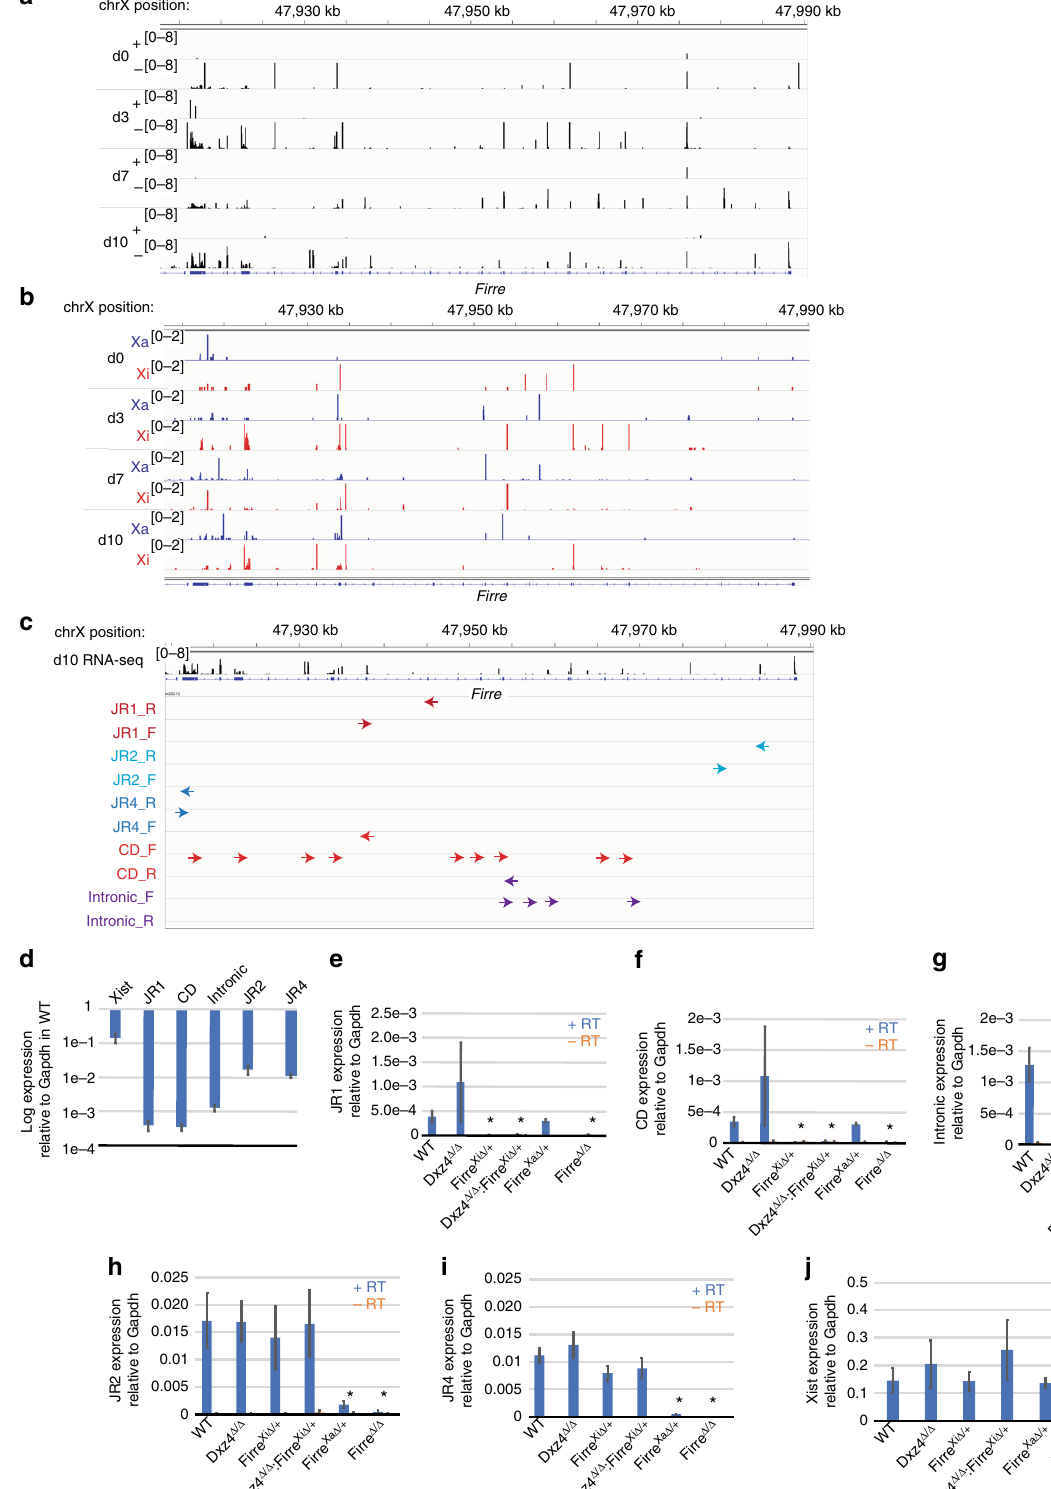
Fig. 5 Allele-speci fi c Firre expression in mESCs. a Expression over Firre during differentiation. b Allelic expression over Firre during differentiation, red = Xi reads, blue = Xa reads. c Positions of Firre primers within the Firre locus. d Expression of Xist or Firre amplicons in d10 wild-type cells normalized to Gapdh (logarithmic scale). e – j Expression normalized to Gapdh measured with JR1 ( e ), CD ( f ), intronic ( g ), JR2 ( h ), JR4 ( i ) Firre primers or Xist primers ( j ) in WT, Dxz4 Δ / Δ Firre Xi Δ / + , Dxz4 Δ / Δ : Firre Xi Δ / + , Firre Xa Δ / + , and Firre Δ / Δ cells. Blue bars are + RT, orange bars are -RT. Asterisks (*) indicate a statistically signi fi cant ( p < 0.05, t -test) difference between normalized expression levels in wild-type and normalized expression levels in the deletion. Error bars show standard error of the mean, three biological